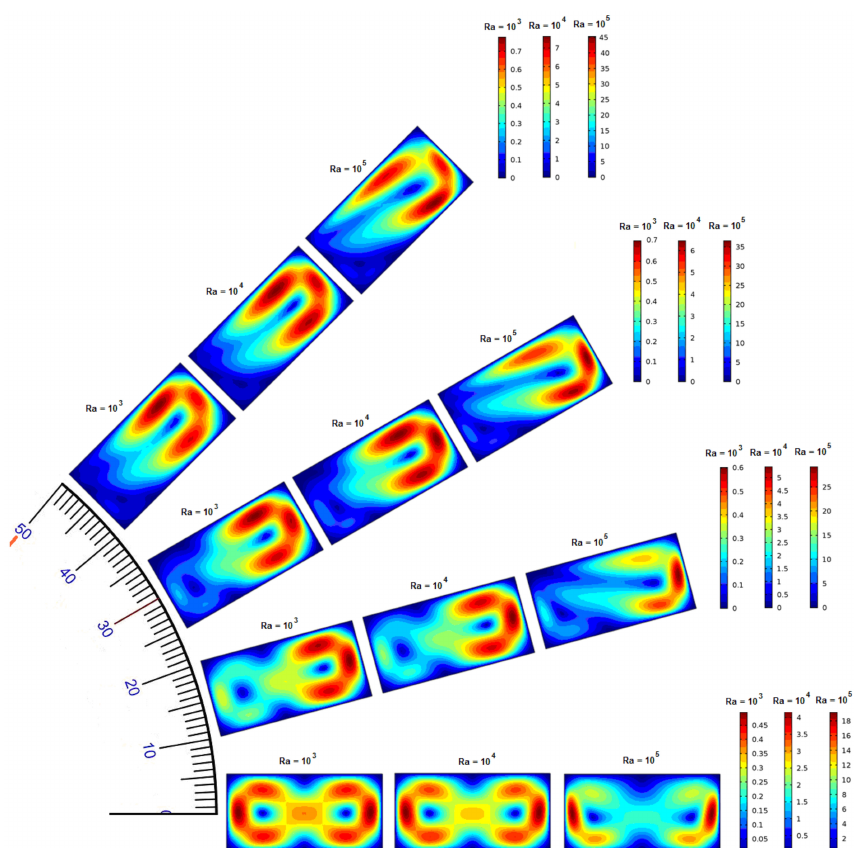
Figure 10. Effects of Rayleigh number and enclosure inclination angle on nanofluid velocity magnitude.